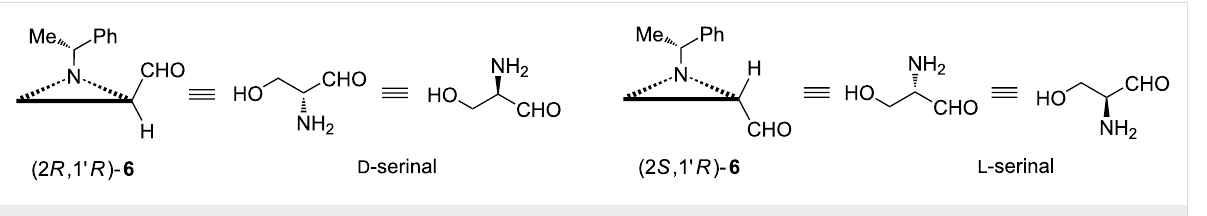
Figure 3: Synthetic equivalency of aziridine aldehydes 6